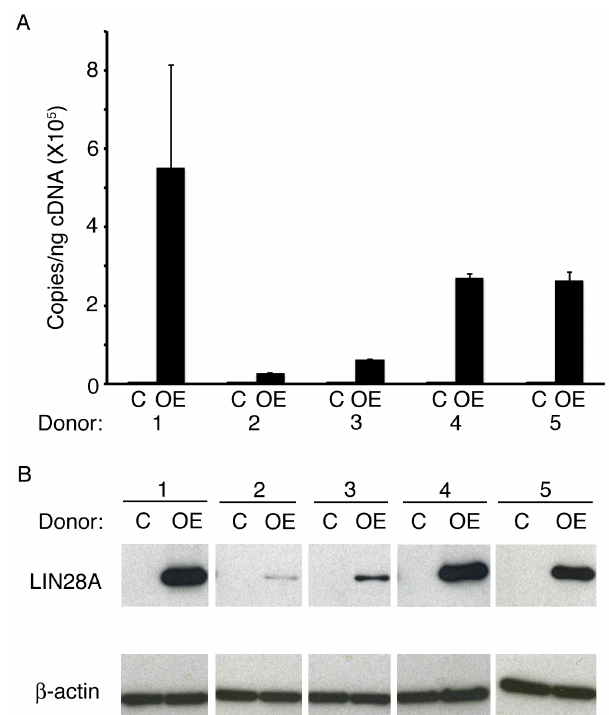
Figure 1. LIN28A over-expression in human sickle erythroblasts was confirmed by (A) Q-RT-PCR quantitation of copy number per nanogram of complementary DNA (cDNA) (copies/ng cDNA) and (B) Western blot analysis. Analyses were performed at culture day 14. Open bars represent control and black bars represent LIN28A over-expression. C: empty vector control; OE: LIN28A over- expression.